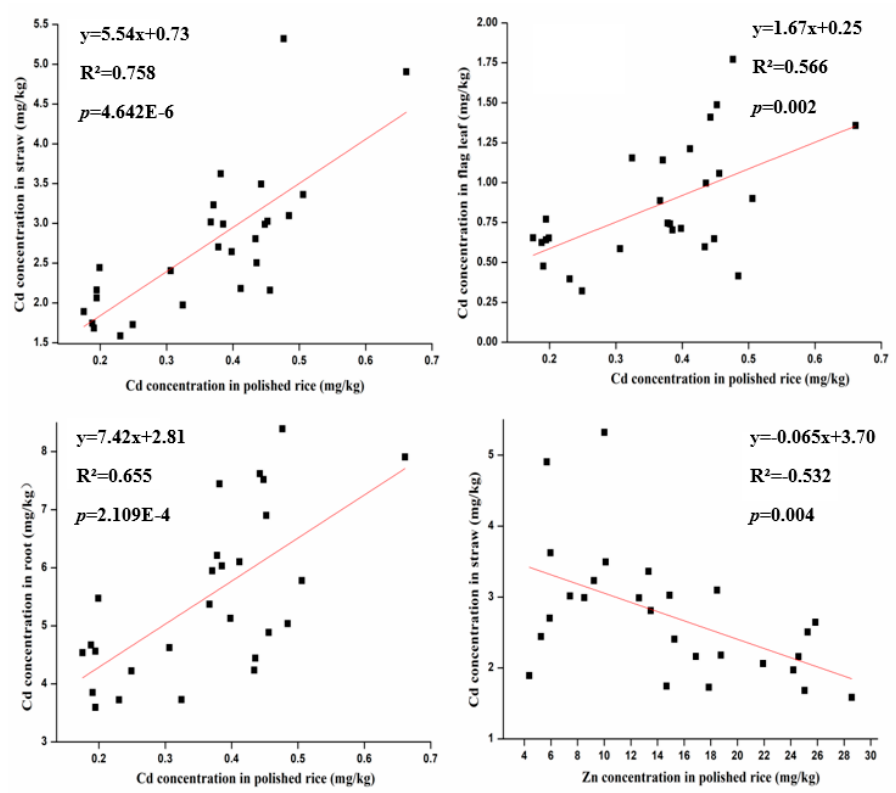
Figure 5. Linear correlations between Cd, Zn concentration in polished rice and Cd concentration in different parts of the plant.